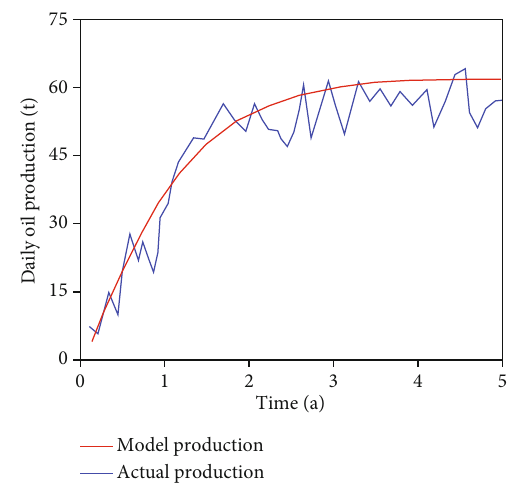
Figure 11: Comparison chart of the actual production and calculated